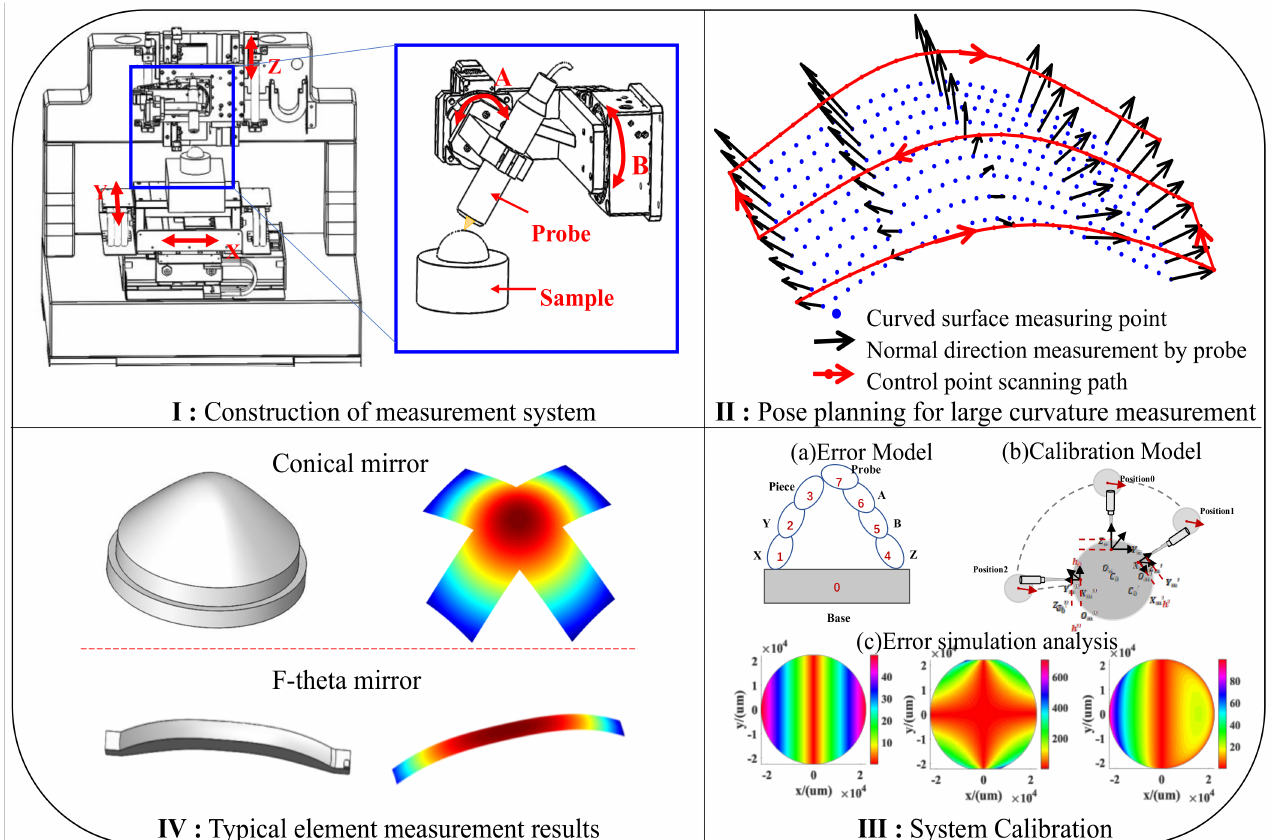
Figure 1. Measuring principle of the highly curved freeform surface measuring